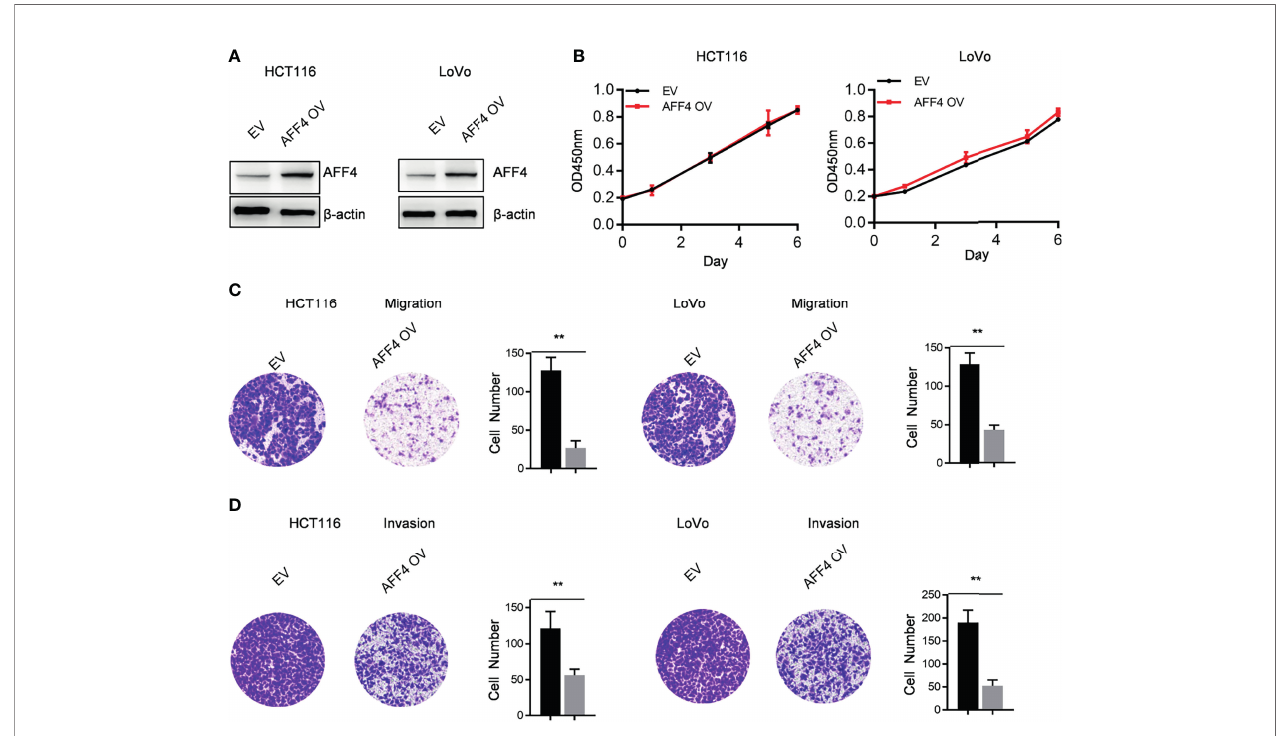
FIGURE 3 | Overexpression of AFF4 hampers CRC cell migration and invasion but not proliferation. Data are from three independent experiments. Data are presented as the mean ± SD or SEM and are analyzed by unpaired t -tests or two-way ANOVA. ** p < 0.01. (A) Western blot assay was performed to determine overexpression ef fi ciency in HCT116 and LoVo cells. b -Actin was performed as an internal control. EV, empty vector, as a blank control; OV, overexpression. (B) CCK-8 assay was performed to measure the effect of AFF4 overexpression on HT29 and DLD-1 cell proliferation. A total of 20,000 cells were seeded in the 48-well plate at the start point and collected at the indicated time points. The calculation value of cell number was readout by OD450 nm using Microplate System. (C, D) Cell migration or invasion was performed by seeding 50,000 HT29 and DLD-1 cells expressing empty vector or AFF4 in the serum-free medium, and migrated (C) or invasive (D) cells through the 8- m m hole were fi xed by 80% cold methanol and stained by crystal violet. Of note, the invasion assay was performed by adding Matrigel in the 8- m m hole. The calculation of cell number was executed by differential interferencecontrast microscope